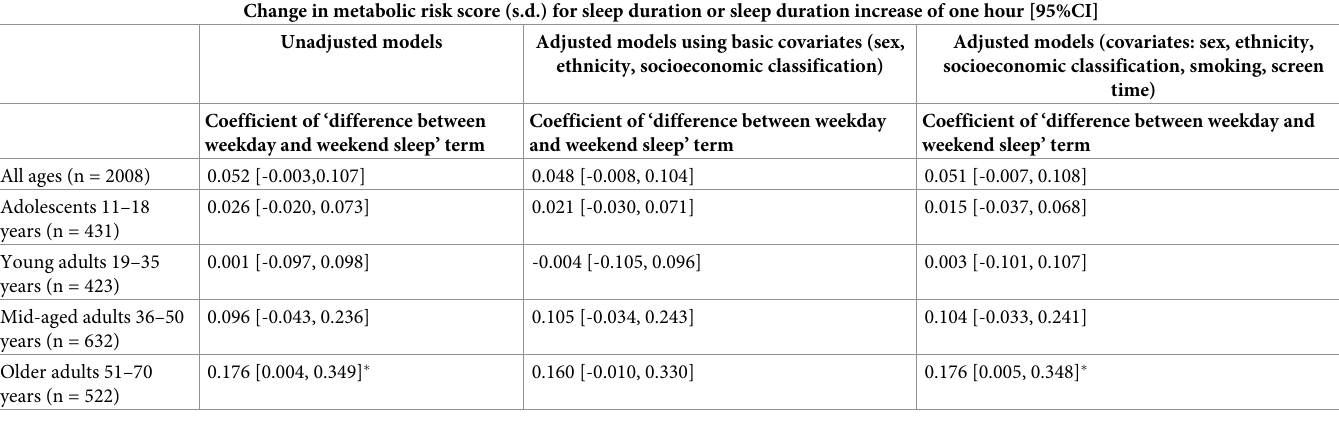
Table 3. Cross-sectional associations between the difference between weekend and weekday night sleep and metabolic risk